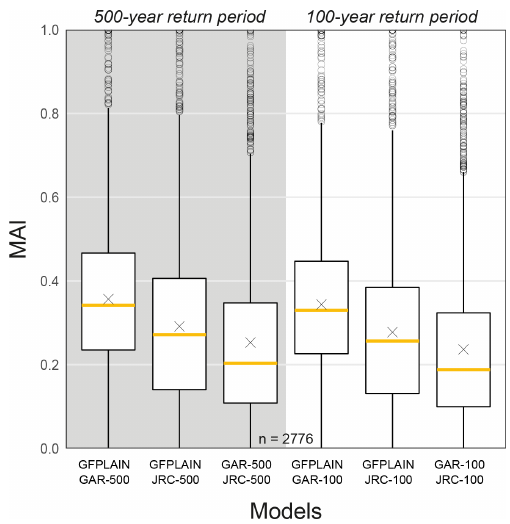
Figure 2. Pairwise evaluation of model agreement between the hydrogeomorphic floodplain map GFPLAIN and the flood hazard maps the GAR and JRC, with a 100- and 500-year return period. The box hinges correspond to the first and third quartile, and the yellow line corresponds to the second quartile (median value). The mean value is indicated with a cross. The whiskers extend from the box hinges with maximum lengths equal to the inter-quartile range multiplied by a factor of 1.5. Values outside of the whiskers are in- dicated with dots. A higher return period shows higher agreement with GFPLAIN, but the choice of flood model influences the level of agreement even more. The flood hazard maps the GAR and JRC show the lowest level of agreement. The index has been calculated here for the 2776 river basins across the world that are covered by all three